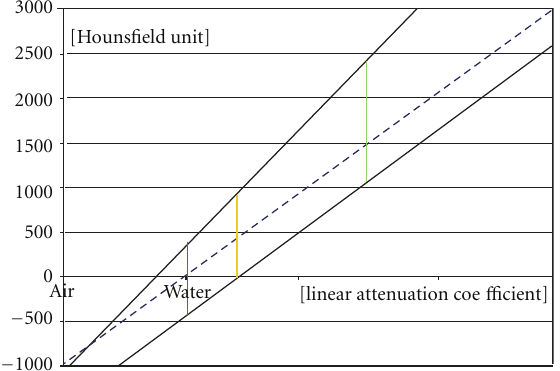
Figure 3: The conventional calibrated (MSCT) and noncalibrated (CBCT) function of the attenuation coe ffi cient and HU. The conventional calibration is represented by an interrupted blue line. The MSCT is calibrated with this method. These functions are di ff erent with CBCT scanners as this calibration is lacking. Two examples are shown as noninterrupted black lines.